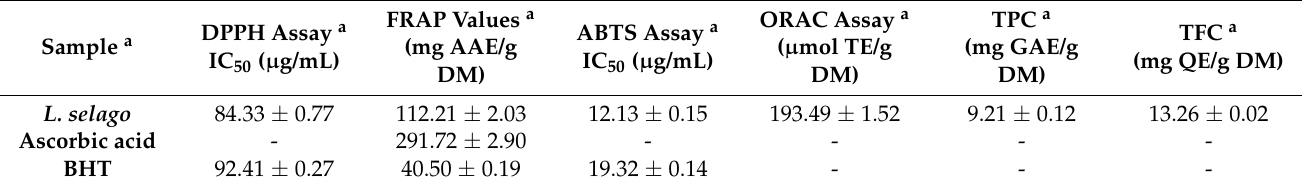
Table 2. Assays for estimating antioxidant activity using DPPH, FRAP, ABTS, ORAC, and evaluation of total phenolic (TPC) and flavonoid content